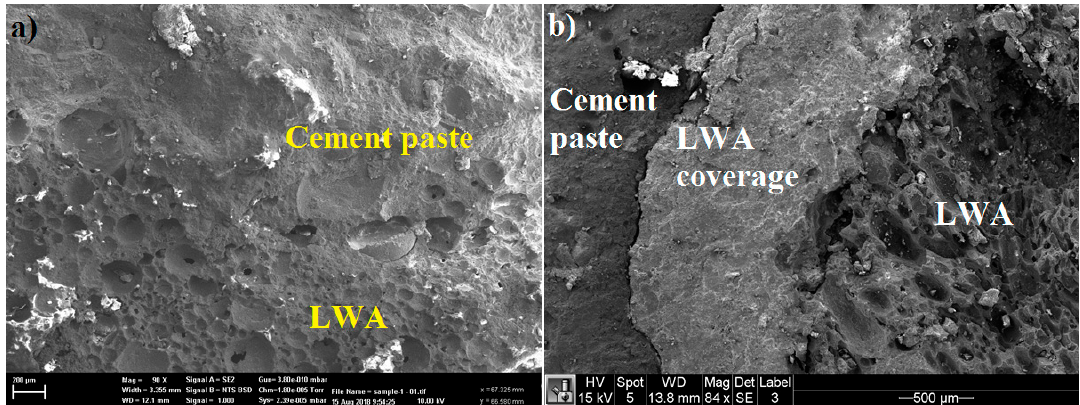
Figure 6. SEM images of samples: ( a ) without coating materials and ( b ) with lightweight aggregate (LWA) coverage.